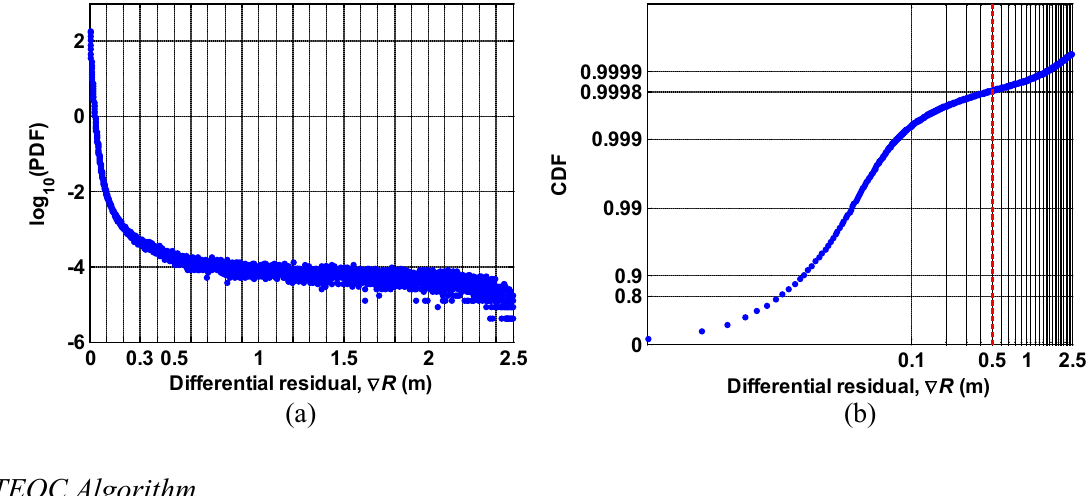
Figure 7. Distribution of differential residuals, R ∇ , derived from data collected for seven consecutive days: ( a ) probability density function and ( b ) cumulative distribution